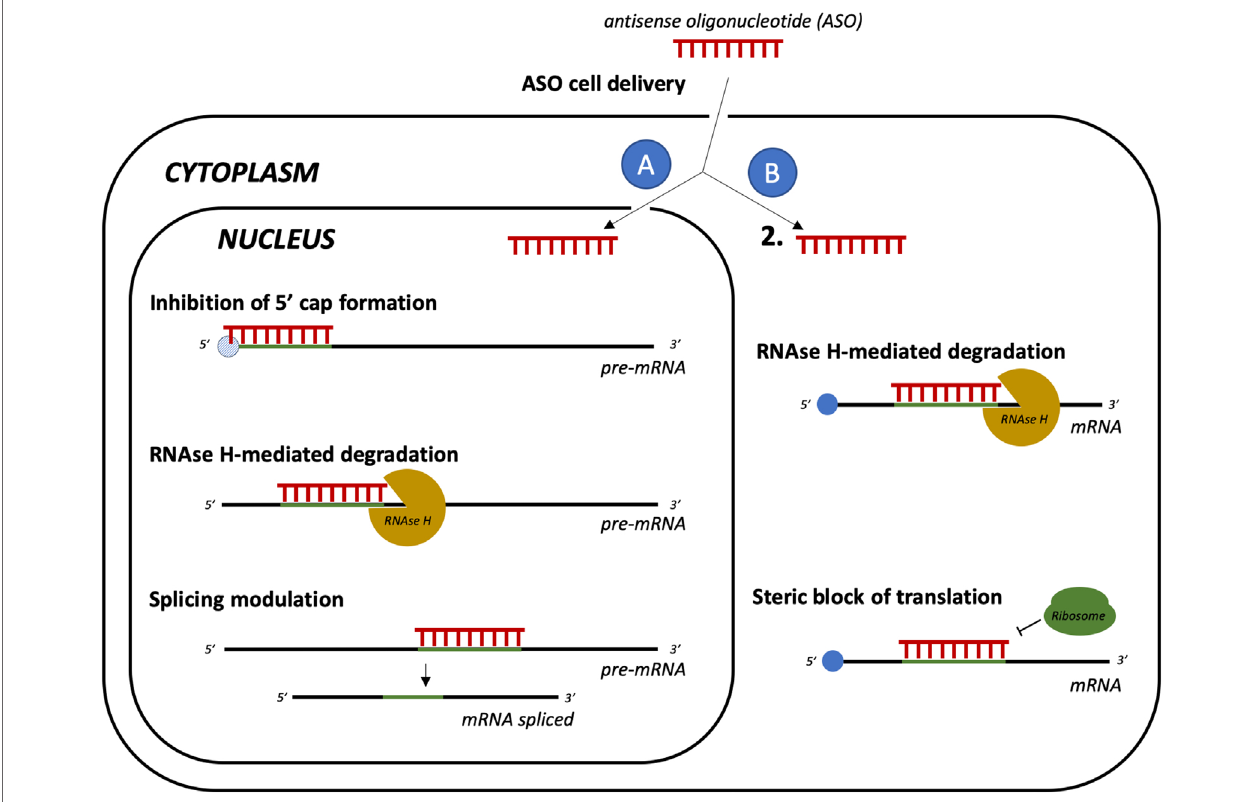
FIGURE 6 | Gene silencing by delivery of antisense oligonucleotides (ASO). Cell-delivered ASOs can act as translation repressors with different mechanisms. If ASOs reach the nucleus (A) , they can form heteroduplexes with the pre-mRNA, which can result in inhibition of 5’ cap formation, recruitment of RNAse H, and mRNA degradation. They may also even act as splicing modulators. In the cytoplasm (B) , ASOs can hybridize with the target mRNA, leading to RNAse H-mediated degradation or to steric block of ribosome binging, resulting in impaired